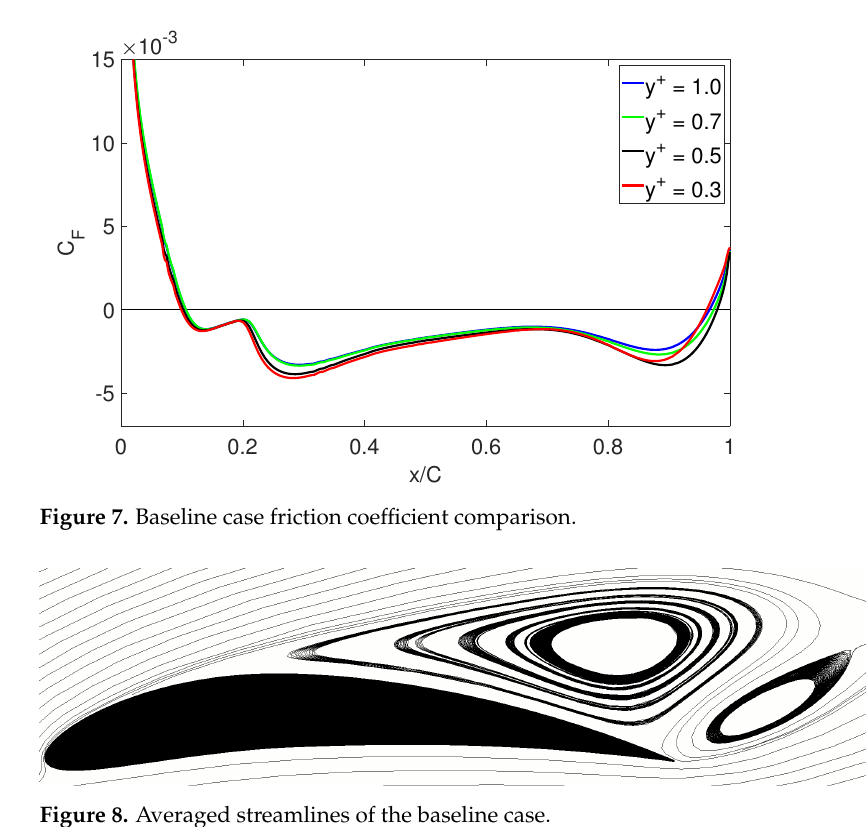
Figure 8. Averaged streamlines of the baseline